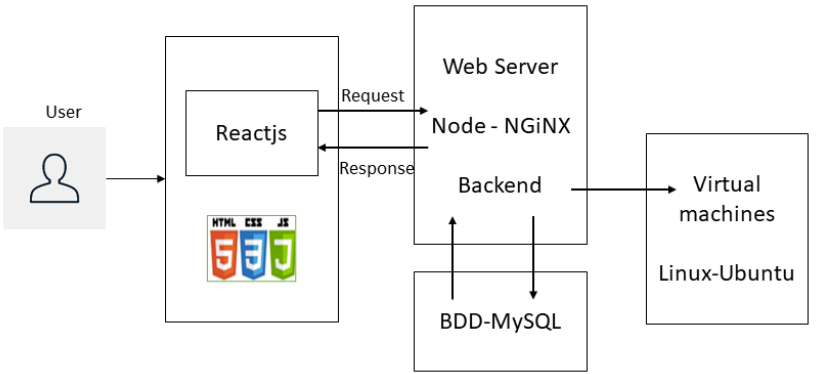
Figure 1. Proposed architecture for the development of the